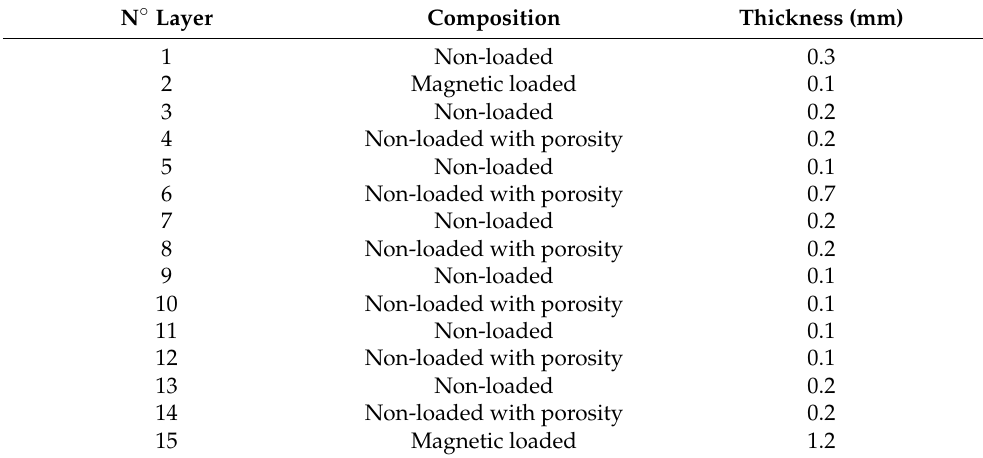
Figure 10. Reflectivity of the optimized structure in Matlab with a goal of − 12 dB at 10° (blue = goal, red = RL) of the optimized structure at 10°, ( a ) without restrictions on the number of different layers, ( b ) number of layers fixed at 3. Table 2. Composition of the optimized solution without restrictions on the number of layers.